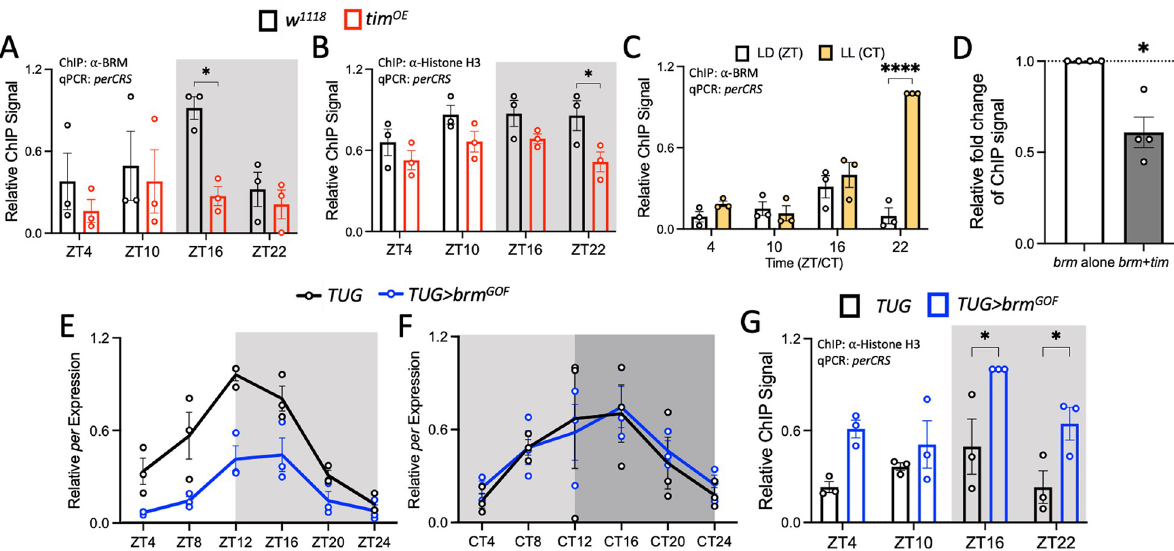
Fig 4. TIM promotes the reduction of BRM occupancy at the per promoter. (A) BRM and (B) Histone H3 occupancy at the perCRS in head nuclear extracts of w 1118 (black) and w 1118 ;ptim(WT) (referred to as tim OE ) (red) flies collected at the indicated time points on LD3. Each data point represents a biological replicate (n = 3), and each biological replicate is an average of at least 2 technical replicates of qPCR. Error bars represent ± SEM. The grey background denotes the dark phase of the LD cycle. Asterisks denote significant p-values: � p < 0.05. (C) BRM occupancy at the perCRS in head extracts of TUG flies entrained for 3 days in 12:12LD and collected on LD4 (white) or LL1 (yellow) (n = 3). (D) BRM binding at the perCRS in S2 cell nuclear extracts expressing either brm alone (white) or brm co-expressed with tim (grey) (n = 4). ChIP signal is relative to the amount of BRM binding in the brm alone condition. (E-F) Steady state mRNA expression of per in the heads of TUG (black) and TUG > brm GOF (blue) flies entrained in LD for 3 days and collected on (E) LD4 and (F) DD1. Steady state cbp20 mRNA levels were used for normalization. Each biological replicate (n = 3) is an average of at least 2 technical replicates of qPCR. The light grey background denotes subjective day, and the dark grey background denotes subjective night in complete darkness (DD) conditions. CircaCompare: (E) MESOR: 9.997e-8, amplitude: 0.0026 and (F) MESOR: 0.688, amplitude: 0.597. (G) Histone H3 occupancy at the perCRS in TUG and TUG > brm GOF flies (n = 3). Asterisks denote significant p-values: � p < 0.05 and ���� p <